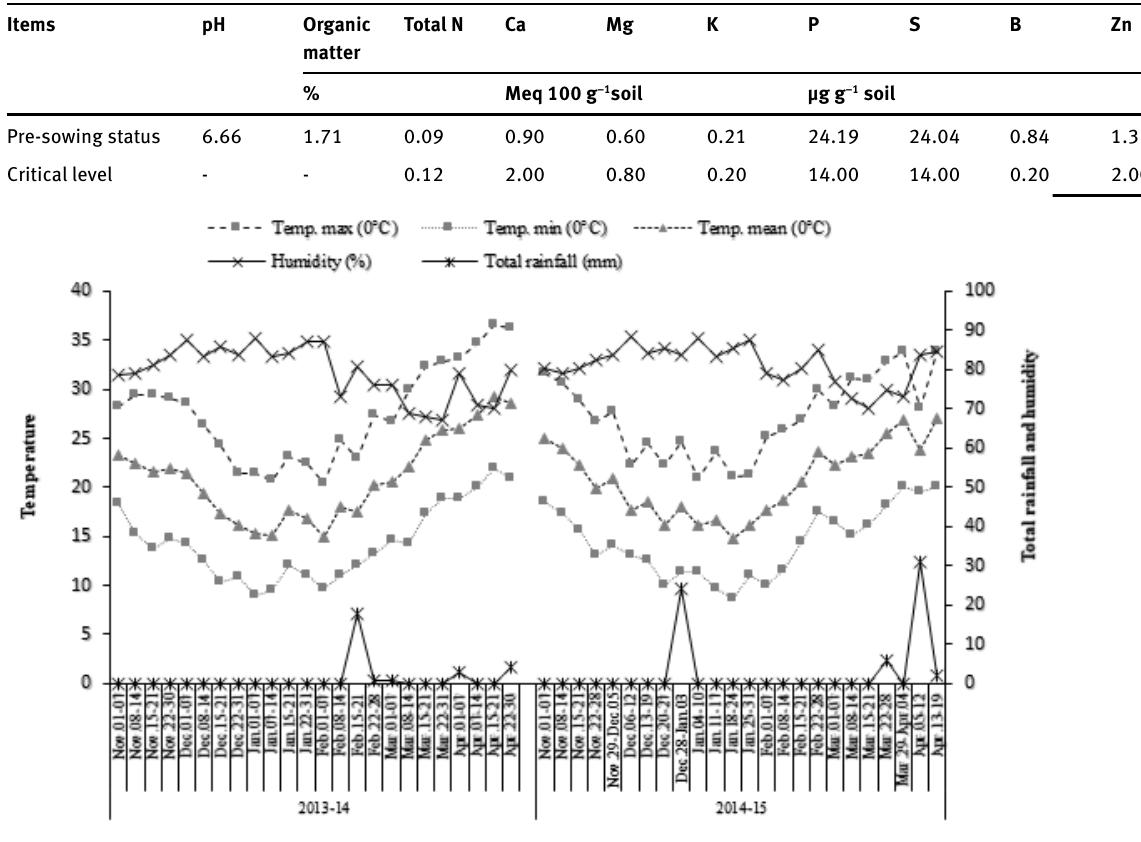
Figure 1: Weekly average temperature, rainfall and relative humidity for two wheat-growing seasons (November to April, 2013-14 and 2014- 15) (Source: Meteorological station, Rajbari-Dinajpur,